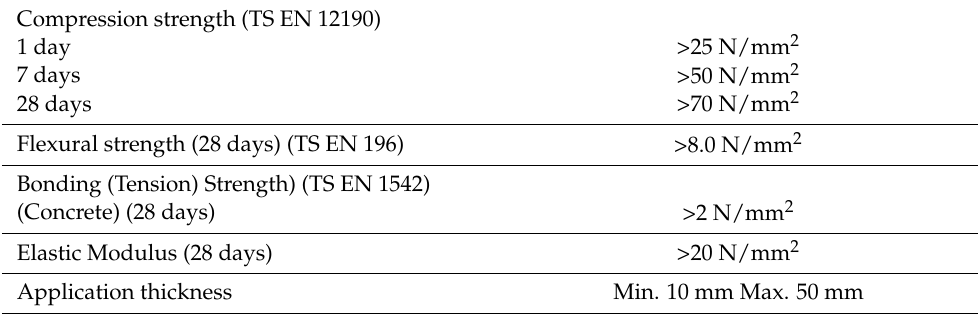
Table 8. Mechanical properties of the repair mortar given by the